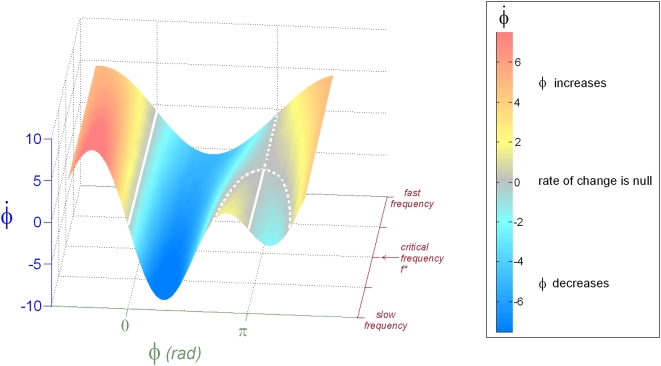
Selection of experimental frequencies guided by the HKB collective variable dynamics.Humans have shown remarkably consistent coordinative (relative phase) behavior in a wide variety of coordination tasks with rhythmic stimuli, a fact captured by the elementary HKB dynamics [11] illustrated here. When asked to synchronize at the same frequency with the stimulus, stable phase patterns are invariably present at (or close to) anti-phase and in-phase for low movement frequencies (typically <2 Hz). This is indicated by the solid lines of fixed points () when  and  for f below a critical frequency f*. For frequencies f>f*, only the fixed point at  is stable. In the VPI experiment, a separate scaling trial in which the frequency is systematically increased is used to determine f*. The value of f* is then used as an upper bound for the choice of frequency parameter, ensuring that pattern instability is not only due to the effect of high frequency in the subject but also comes from conflicting tasks.